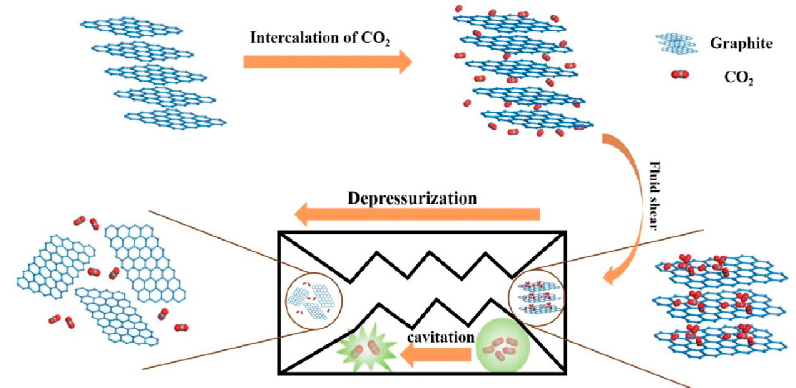
Figure 13. The mechanism drawing of exfoliation graphene nanosheets with supercritical CO 2 and micro-jet exfoliation. Reproduced from [73]. Copyright IOP Publishing, 2017.